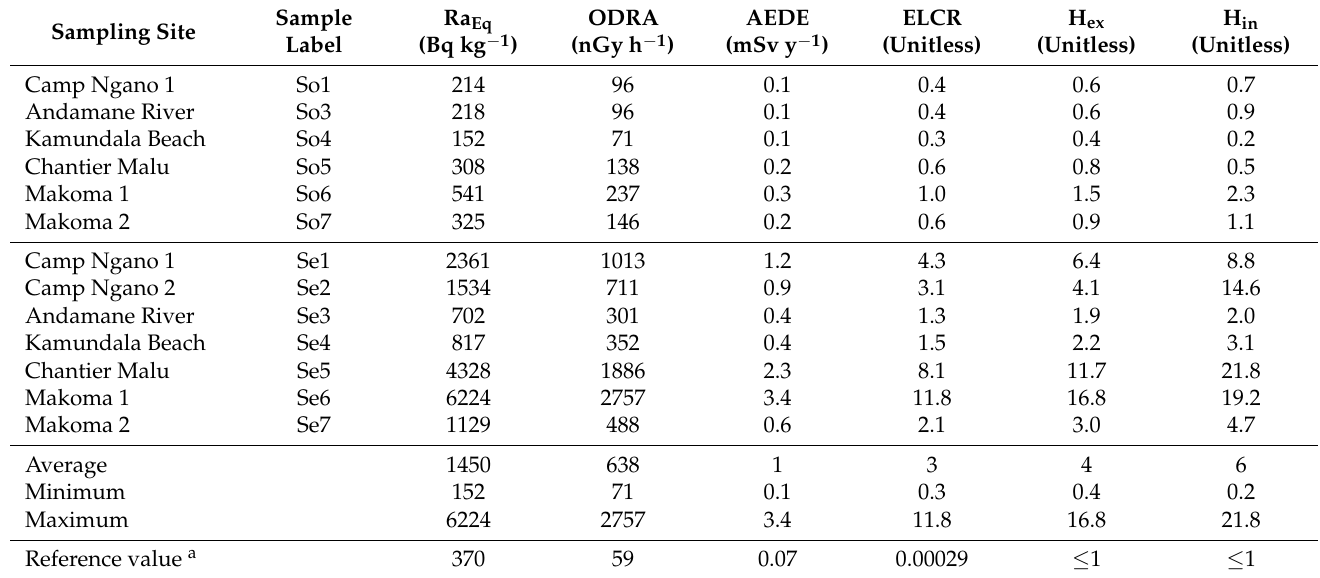
Table 4. Radium equivalent activity index (Ra Eq ), outdoor gamma absorbed dose rate (ODRA), annual effective dose equivalent (AEDE), excess lifetime cancer risk (ELCR), and hazard indices (H ex and H in ) for the investigated